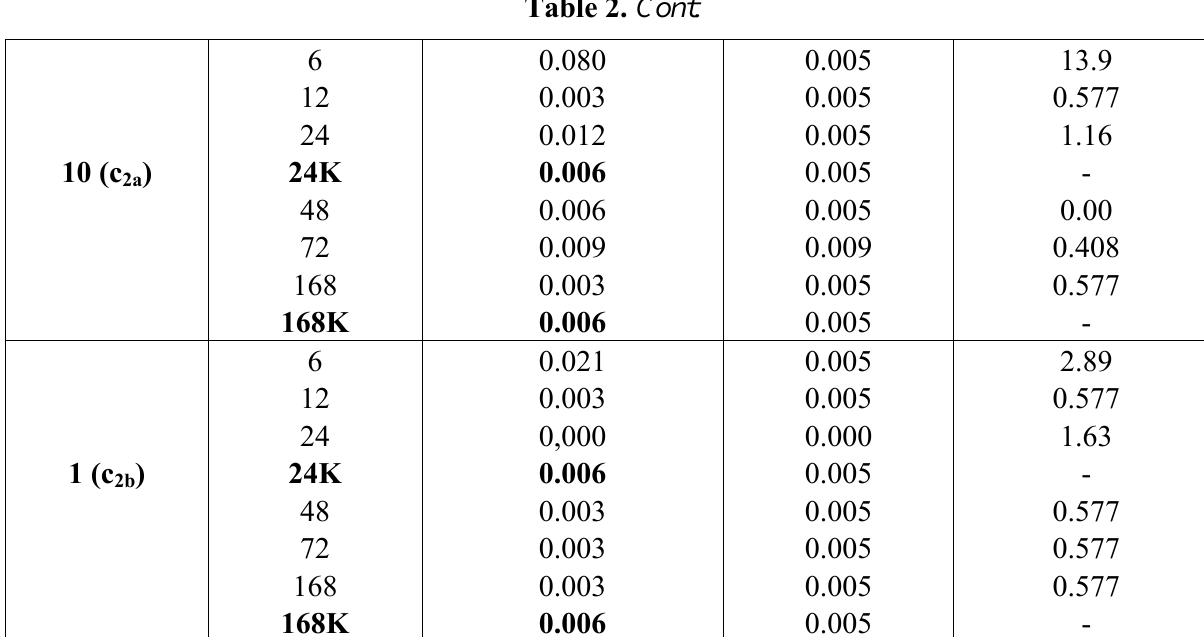
Figure 3. Dependence of the of flavonolignans and taxifolin content in callus culture Silybum marianum related to the elicitor exposure compared between treatments with three different concentrations of compound 2 and between controls. All experimental analyses were carried out in a minimum of three independent samples for each elicitation period and each concentration of elicitor.